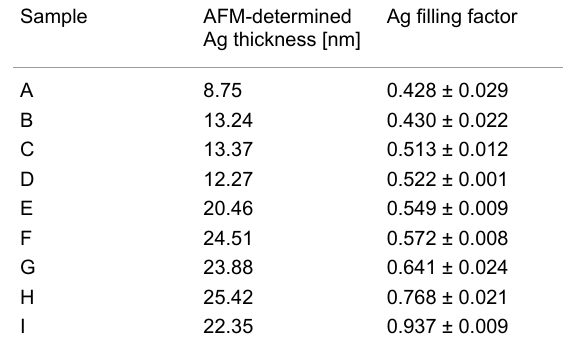
Table 1: The AFM-determined thicknesses of semicontinuous Ag films and estimated values of metal filling